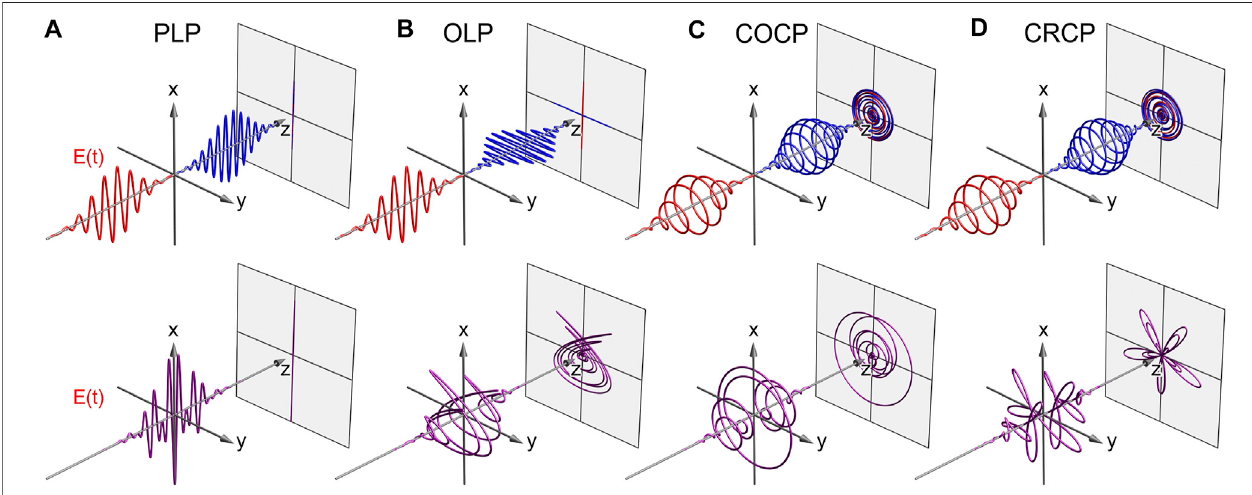
FIGURE 7 | Bichromatic pulse sequences. The projection in z -direction visualized the time-dependent electric fi eld vector at the position of the atom or molecule. (A) PLP, (B) OLP, (C) COCP and (D) CRCP bichromatic pulse sequences. Upper fi gures: Sequence with separated pulses τ > 2 Δ t , lower fi gures: Coinciding pulses at τ (cid:2)